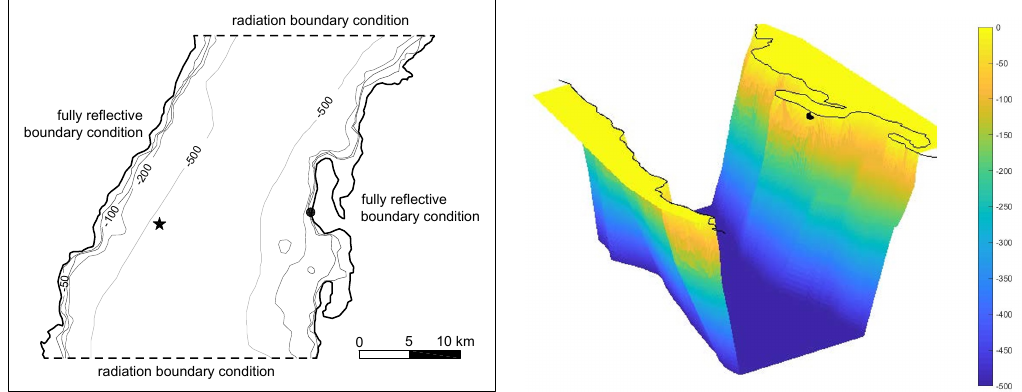
Figure 3. Reconstruction of the Tañon Strait bathymetry, used in the 3D numerical domain ( right plot ). In the ( left plot ) the star indicates the earthquake epicenter, and the dot the measuring